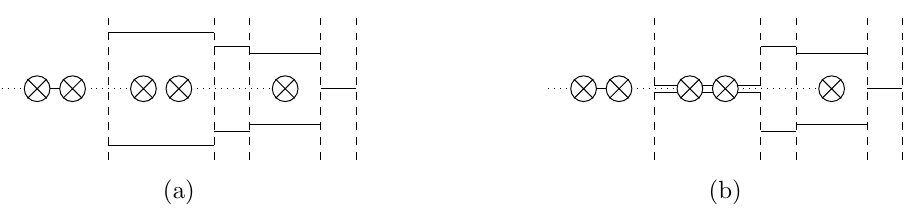
Figure 39. Naive attempt at KP transition on the model with ~k s = (0 ; 0 ; 1 ; 1 ; 3). (a) Higgs branch of the model. (b) After splitting the D3-brane in three segments, the middle one can acquire non zero position ~x along the directions spanned by the half NS5-branes. However, when the limit is taken where this position is in(cid:12)nite and the segment is e(cid:11)ectively removed from the system, the